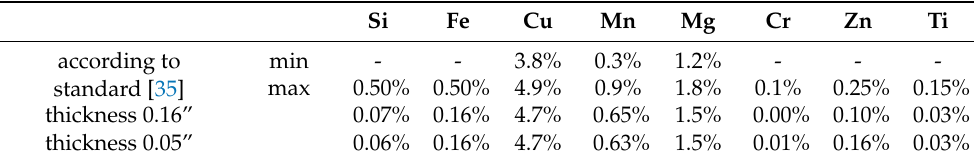
Table 1. The content of main components (apart from aluminum) of 2024-T3 alloy (wt %).